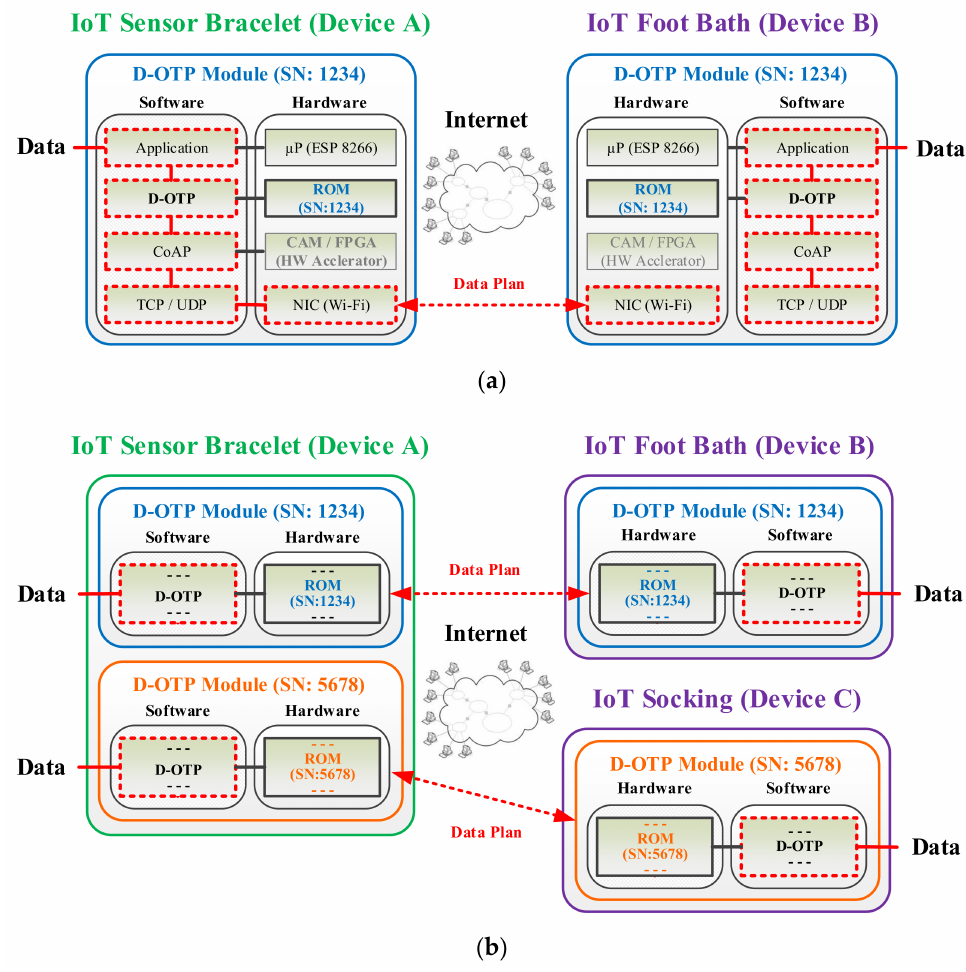
Figure 6. D-OTP architectures for directly transmitting data between ( a ) two or ( b ) three healthcare IoT